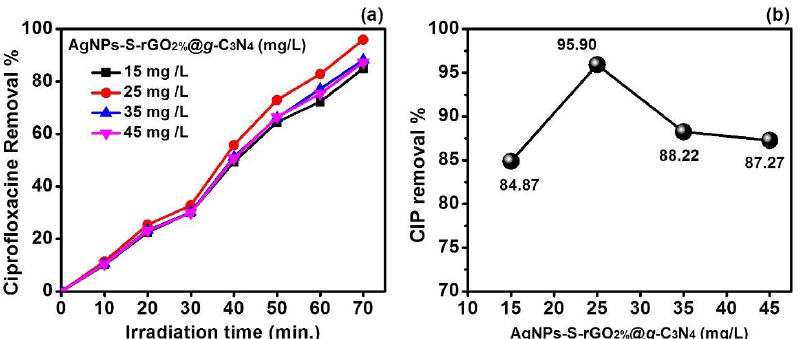
Figure 14. ( a , b ) Effect of AgNPs-S-rGO 2% @ g -C 3 N 4 dosage over CIP degradation at constant CIP con- centration (25 mg/L) and constant pH-6.